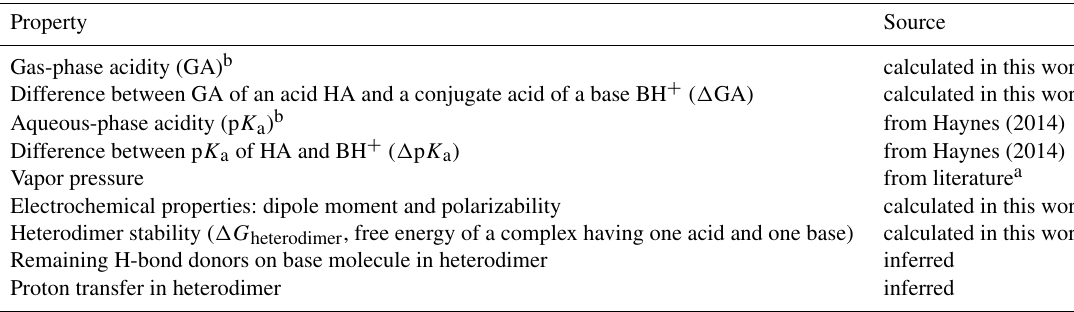
Table 2. Experimental and calculated properties examined in this